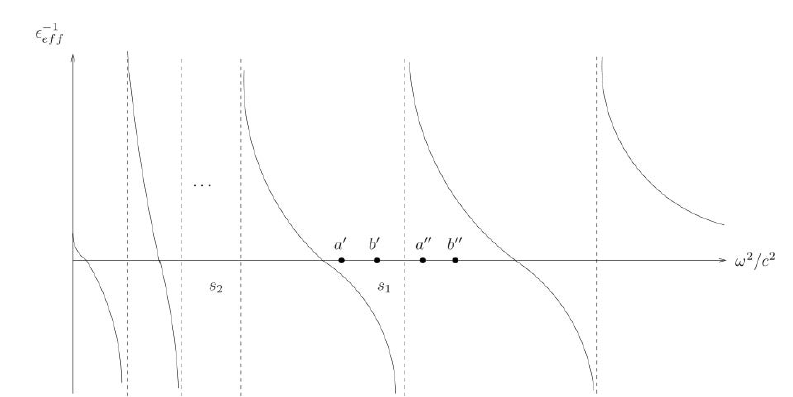
Figure 4. The relation between (cid:101) − 1